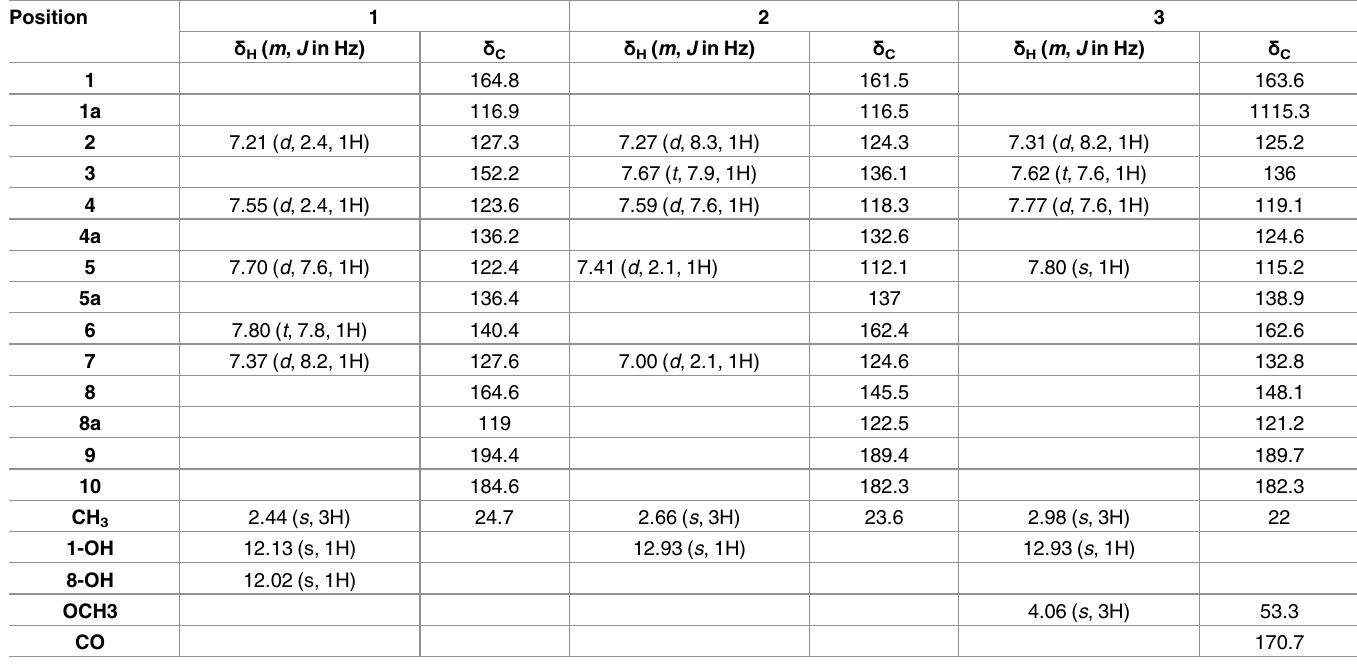
Table 1. 1 H (500 MHz) and 13 C (125 MHz) NMR Spectral data for compounds 1, 2 and 3 isolated from root of A . pulcherrima